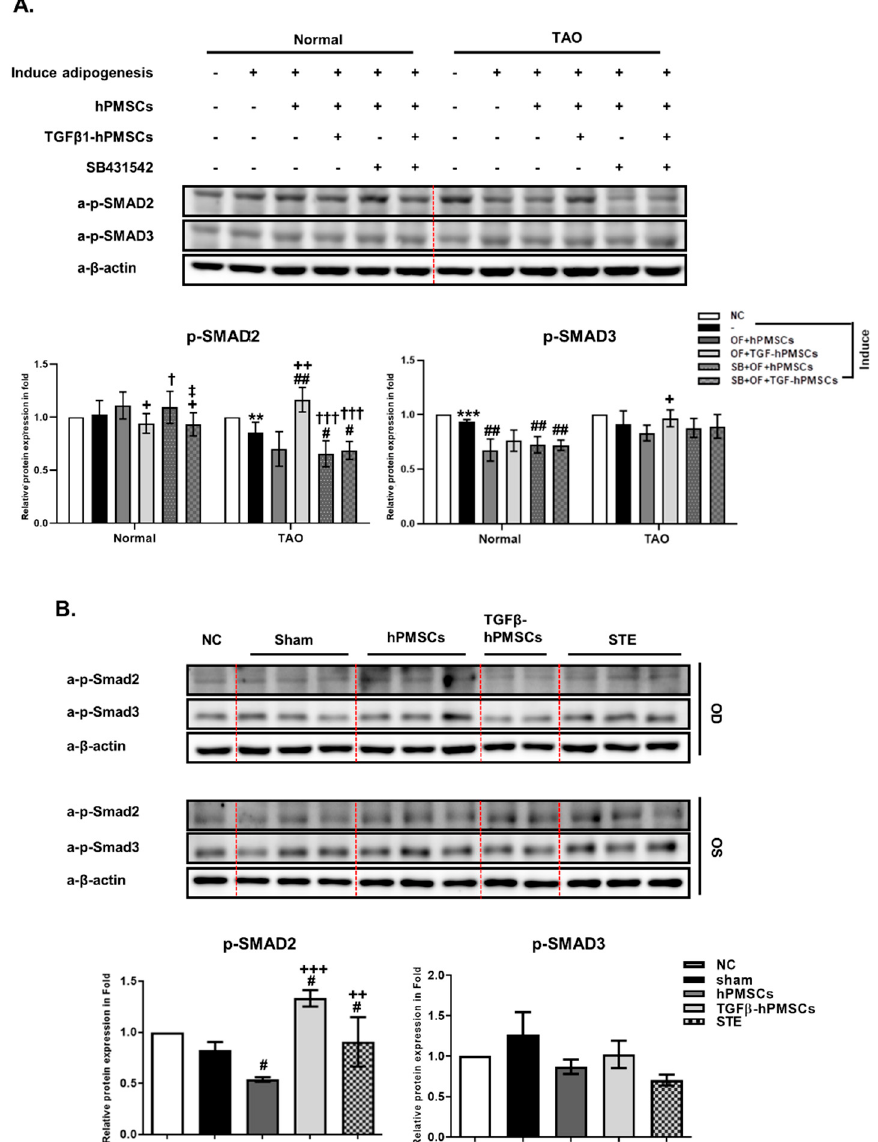
Figure 4. TGF β -hPMSC co-culture regulated SMAD signaling pathway. ( A ) Protein lysates from TAO OFs were used to western blot for analysis of phosphorylation-SMAD protein on day 10 (e.g., p-SMAD2 and p-SMAD3) expression levels (** p < 0.01, *** p < 0.001 vs. Negative control vs. adipogenesis induced OFs; # p < 0.05, ## p < 0.01 vs. adipogenesis-induced OFs; + p < 0.05, ++ p <0.01 vs. OF + hPMSCs; † p < 0.05, ††† p < 0.001 vs. OF + TGF β -hPMSCs; ‡ p < 0.05 vs. SB + OF+ hPMSCs). ( B ) Mouse orbital tissue lysates were investigated by western blot to detect p -Smad2 and p-Smad3 expression levels. Expression levels were normalized to β -actin, and the values of OS were divided OD. Data were presented as a fold change (mean± SEM) (# p < 0.05 vs. Sham; ++ p < 0.01, +++ p < 0.001 vs. hPMSCs). Sham n = 3, hPMSCs n = 3, TGF β -hPMSCs n = 2, STE (steroid) n = 3.